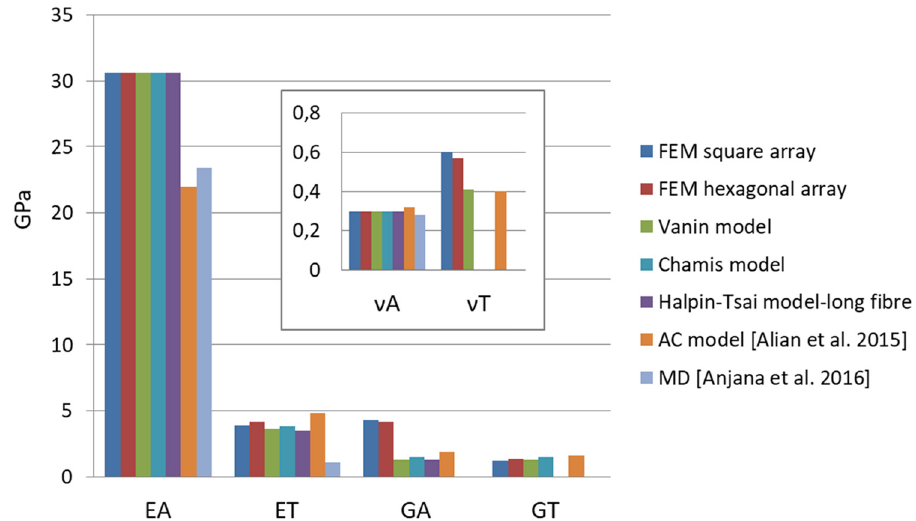
Figure 5: Comparison of the effective elastic properties of CNT – polymer nanocomposite according to different models ( EA, axial Young ’ s modulus; ET, transverse Young ’ s modulus; GA, axial Kirchhoff ’ s modulus; and GT, transverse Kirchhoff ’ s modulus; vA, axial Poisson ’ s ratio, vT, transverse Poisson ’ s ratio ) .